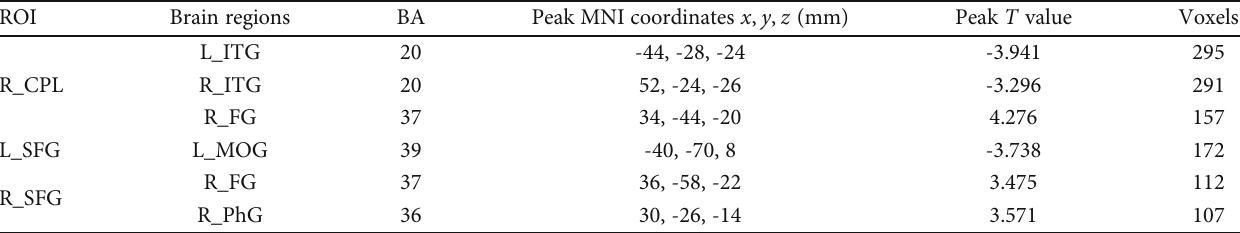
Figure 4: Compared with HC, the acute mTBI patients exhibited decreased negative CBF connectivity between the seed ROI of the right CPL and the right ITG as well as the left ITG and increased positive CBF connectivity with the right FG; the acute mTBI patients showed decreased negative CBF connectivity between the seed ROI of the left SFG and the left MOG; the acute mTBI patients exhibited increased negative CBF connectivity between the seed ROI of the right SFG and the right FG as well as the right PhG. Table 4: Brain regions with signi fi cant group di ff erences in CBF